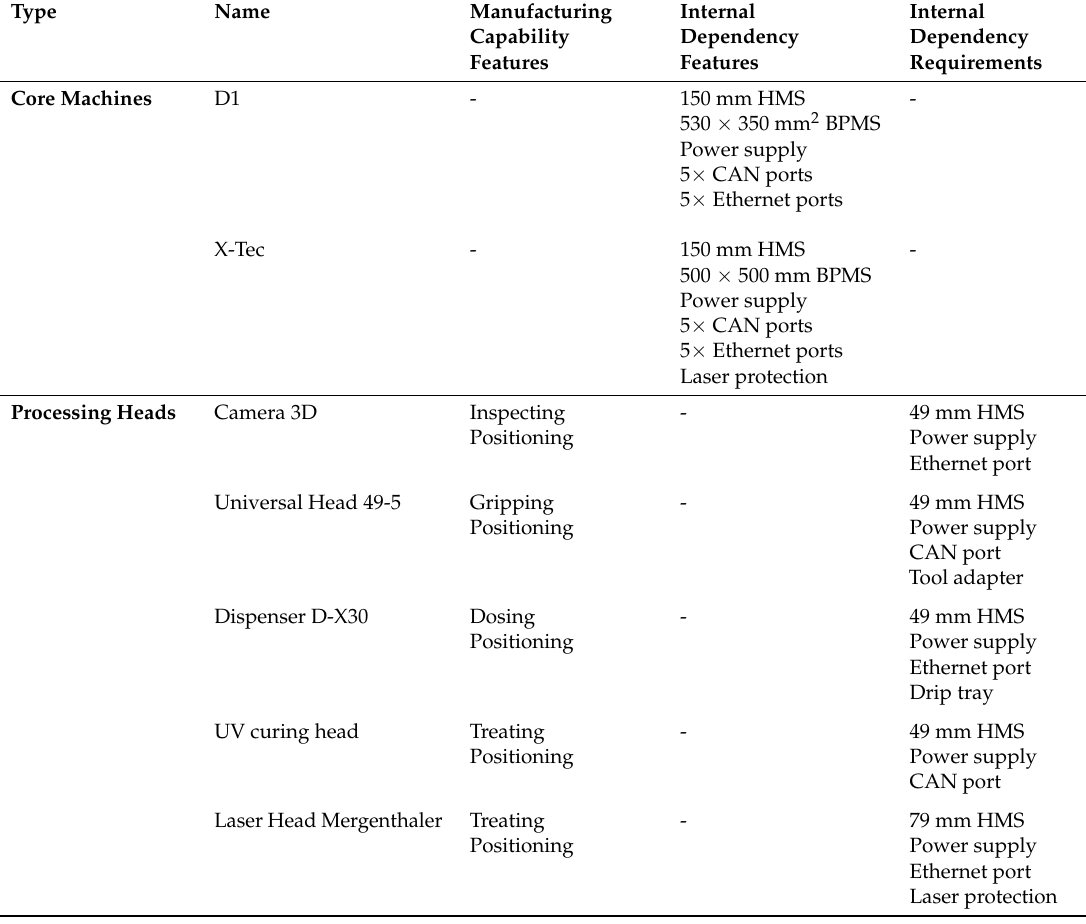
Table 8. Core machines and processing heads used for the planning tool for micro-assembly (PlaTooMA). HMS, head mounting space; BPMS, base plate mounting